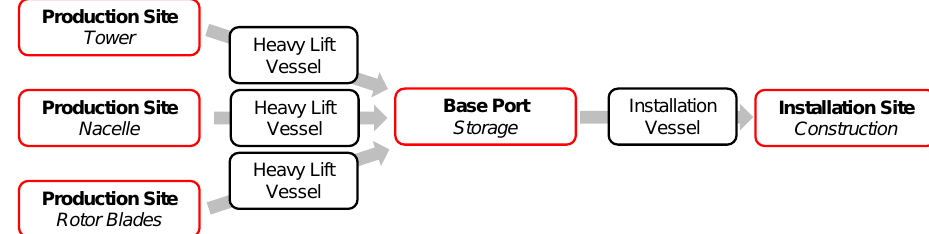
Figure 1. Conventional installation concept